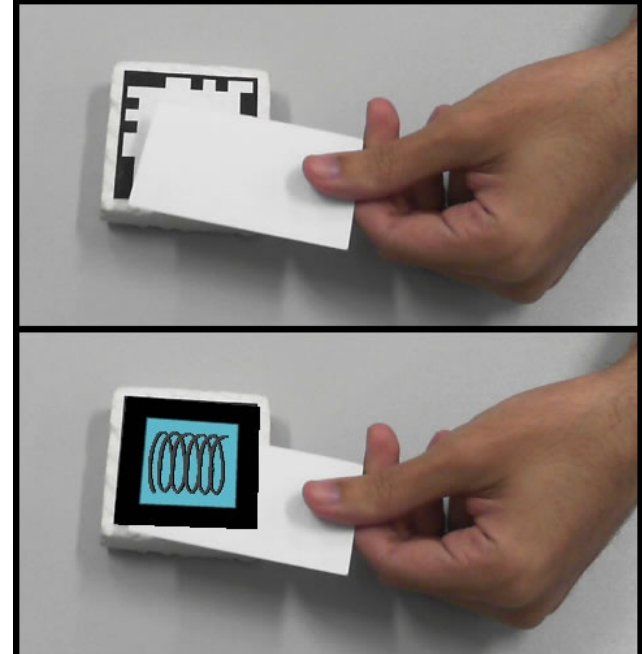
Fig. 8. The original image, on the top, shows that most of the marker is occluded. Even though, in the bottom it is possible to see that the block is tracked and the augmented reality content is rendered over